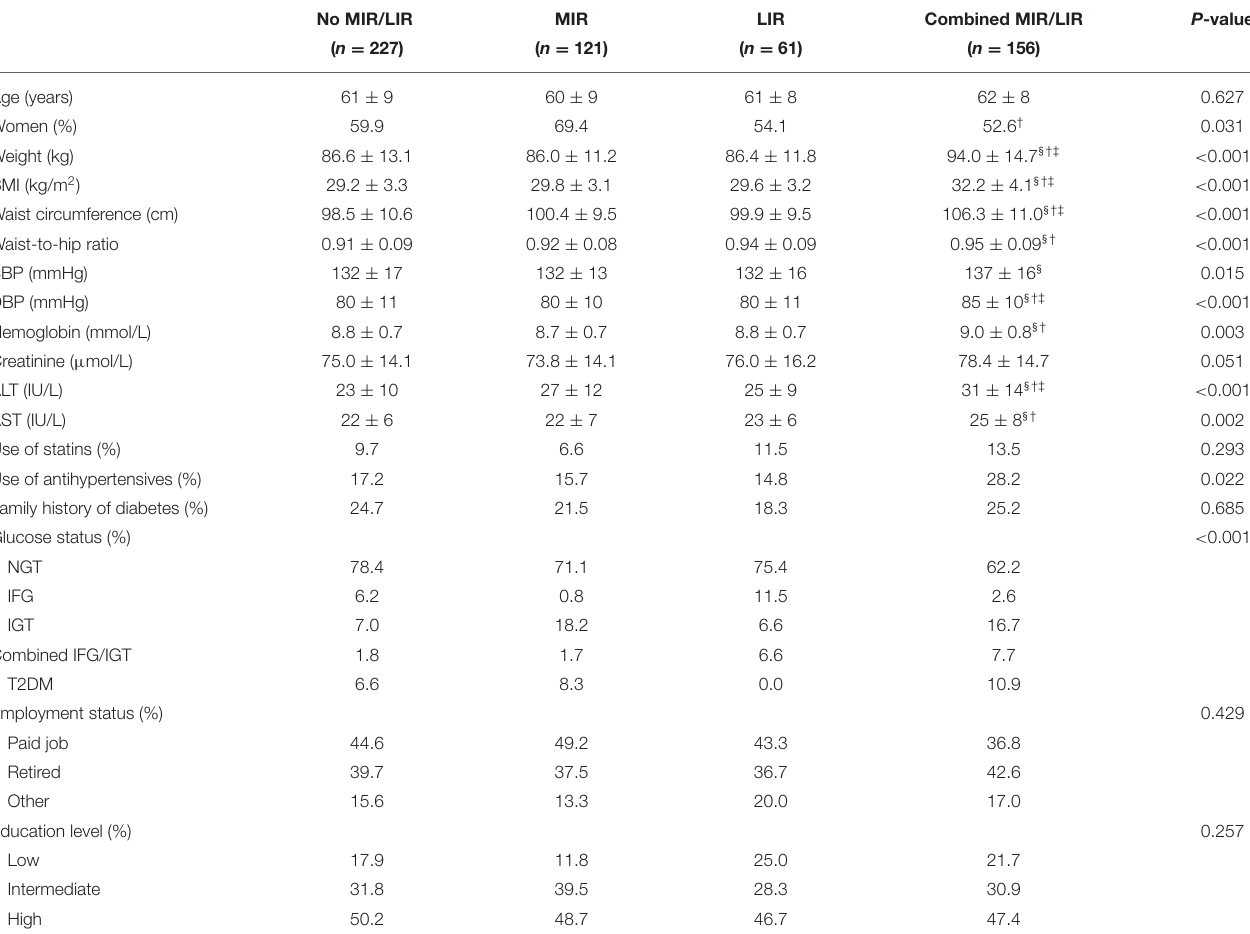
TABLE 2 | Characteristics of screened participants according to insulin resistance phenotype. No MIR/LIR MIR LIR Combined